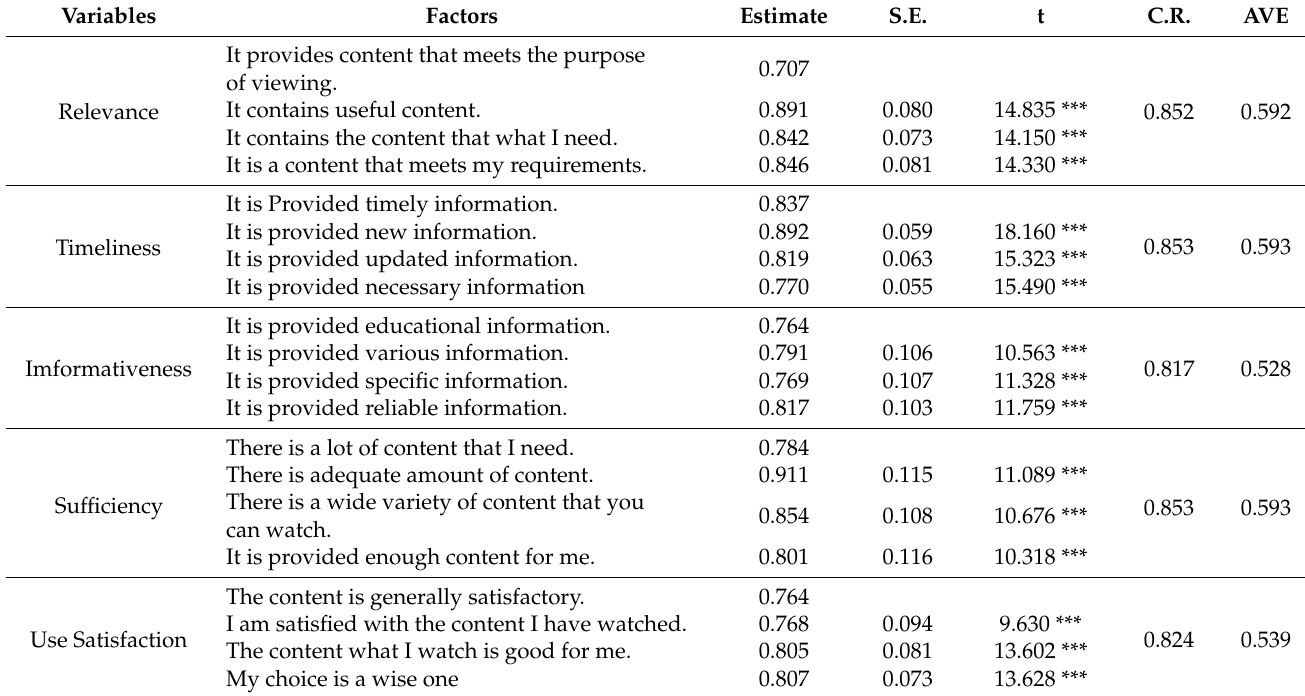
Table 2. Confirmatory Factor Analysis and Conceptual